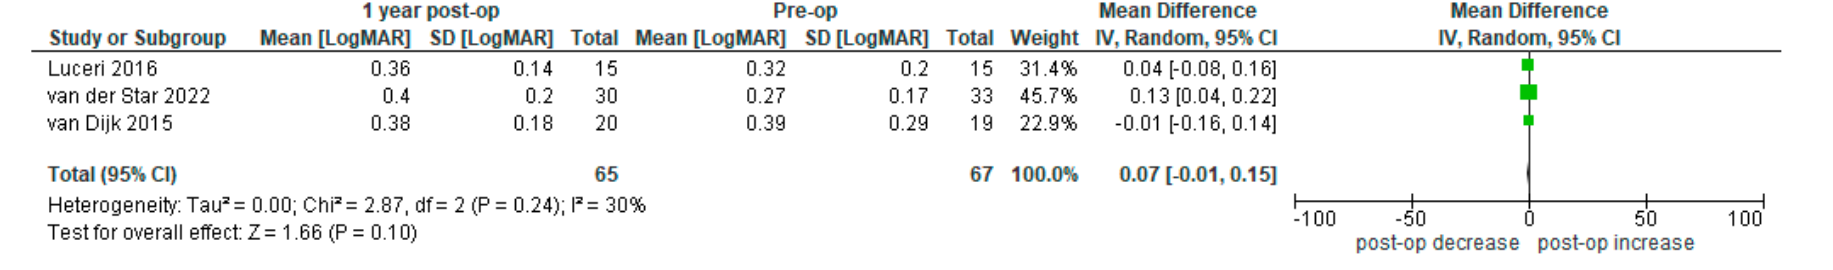
Figure A14. Difference in best contact lens-corrected visual acuity across 3 studies [31,36,43].